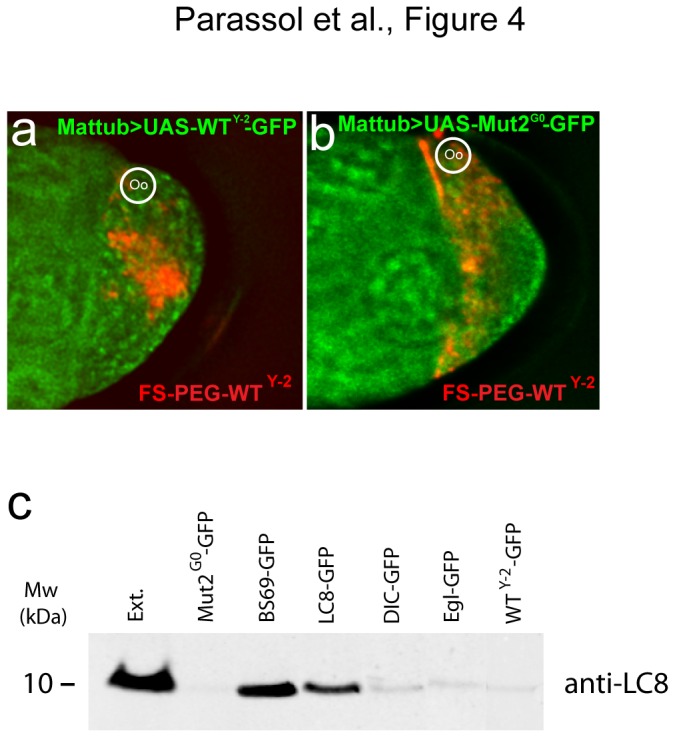
LC8 binding peptides interact with endogenous LC8.(a) Overexpression of WTY-2 -GFP tagged peptide prevents the localization of FS-PEG-WTY-2. (b) Overexpression of Mut2G0-GFP tagged peptide does not affect FS-PEG-WTY-2 localization. Oocytes are shown 45 min after injection. (c) Immunoblot of oocyte extracts expressing GFP tagged peptides (Mut2G0-GFP, BS69-GFP, DIC-GFP, WTY-2-GFP Egl-GFP) or full length LC8 (LC8-GFP). Immunoprecipitation was performed using an anti-GFP antibody and western blot using an anti-LC8. Full length LC8 as well as LC8 binding peptides except for Mut2G0 associate with endogenous LC8 under physiological salt conditions.